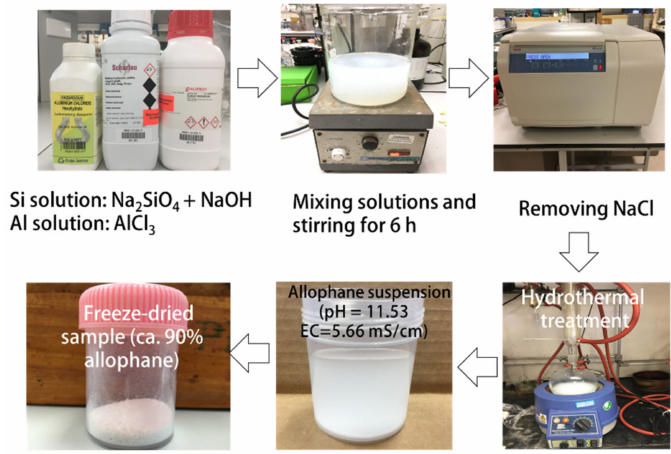
Figure 1. The scheme of the synthesis processes of